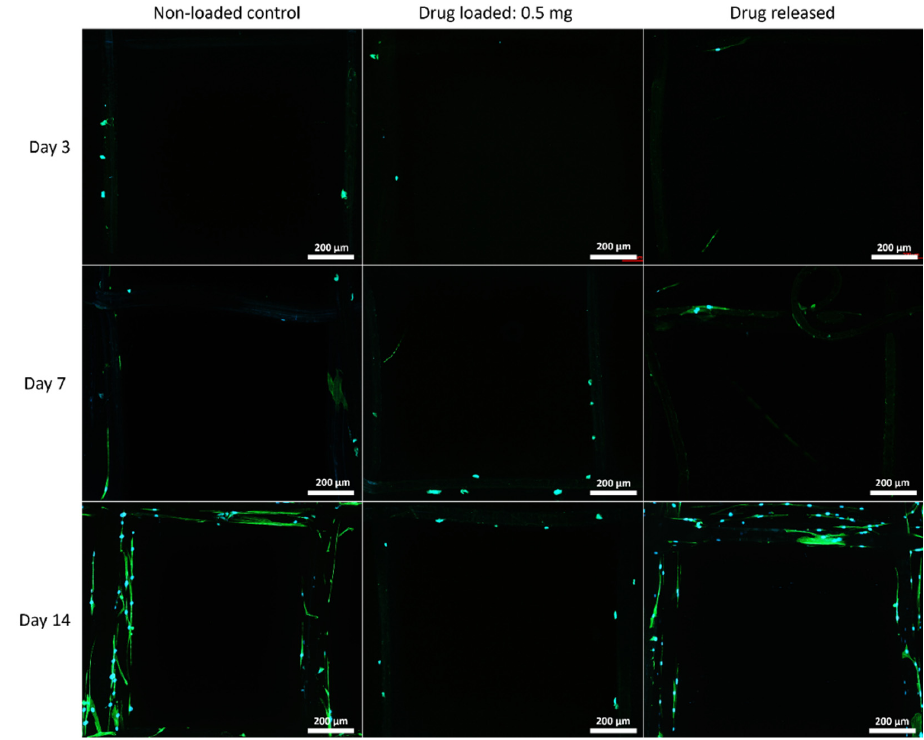
Figure 8. MSC cell morphology on 90:10 mesh groups at all time points. Cell nuclei are shown in blue and cytoskeleton shown in green.